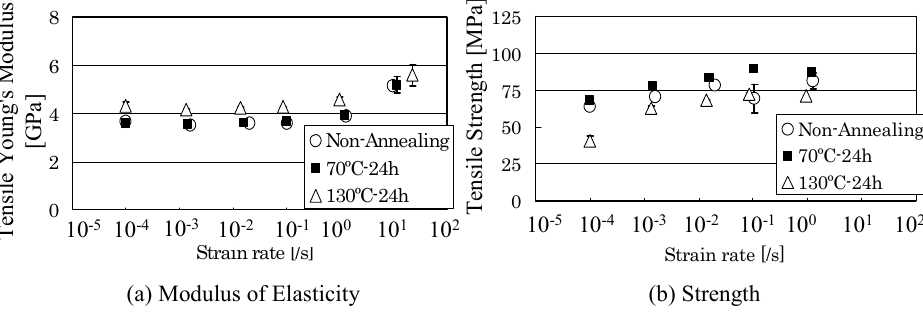
Figure 3 The results of tensile tests of PLLA specimens with strain